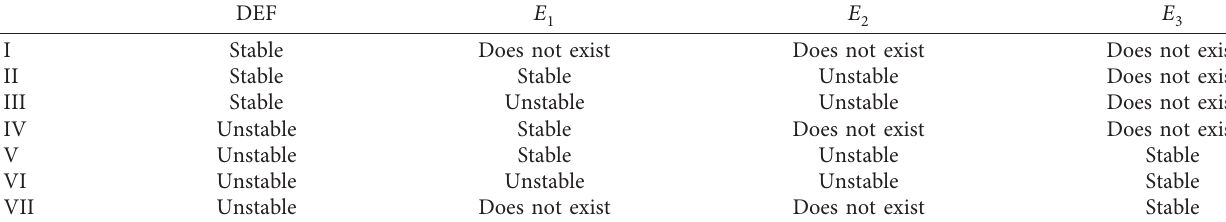
Table 2: Stability of the steady states in different regions in Figure